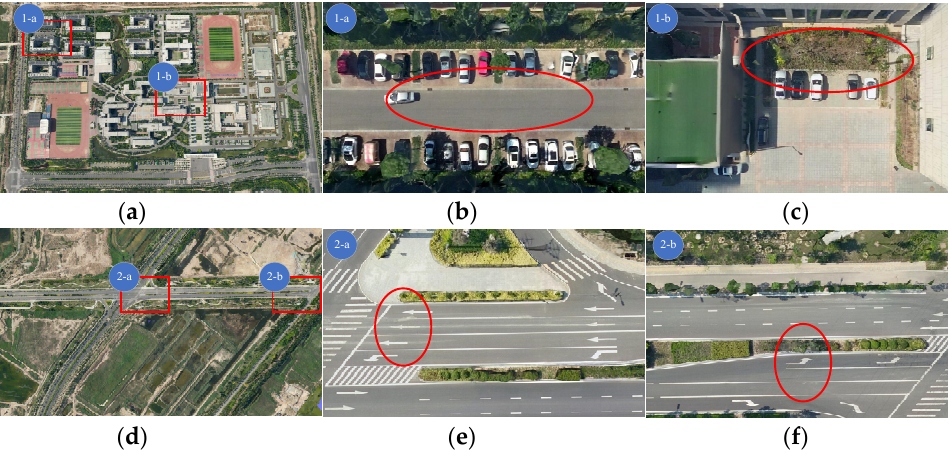
Figure 15. Texture reconstruction results obtained via the method proposed in this article. ( a ) texture results for building area; ( b , c ) the texture reconstruction result of building area via the method proposed in this article; ( d ) texture results for non-building area; ( e , f ) the texture reconstruction results of non-building area via the method proposed in this article. red frame is the local detail area; red circle is the experimental comparison area.